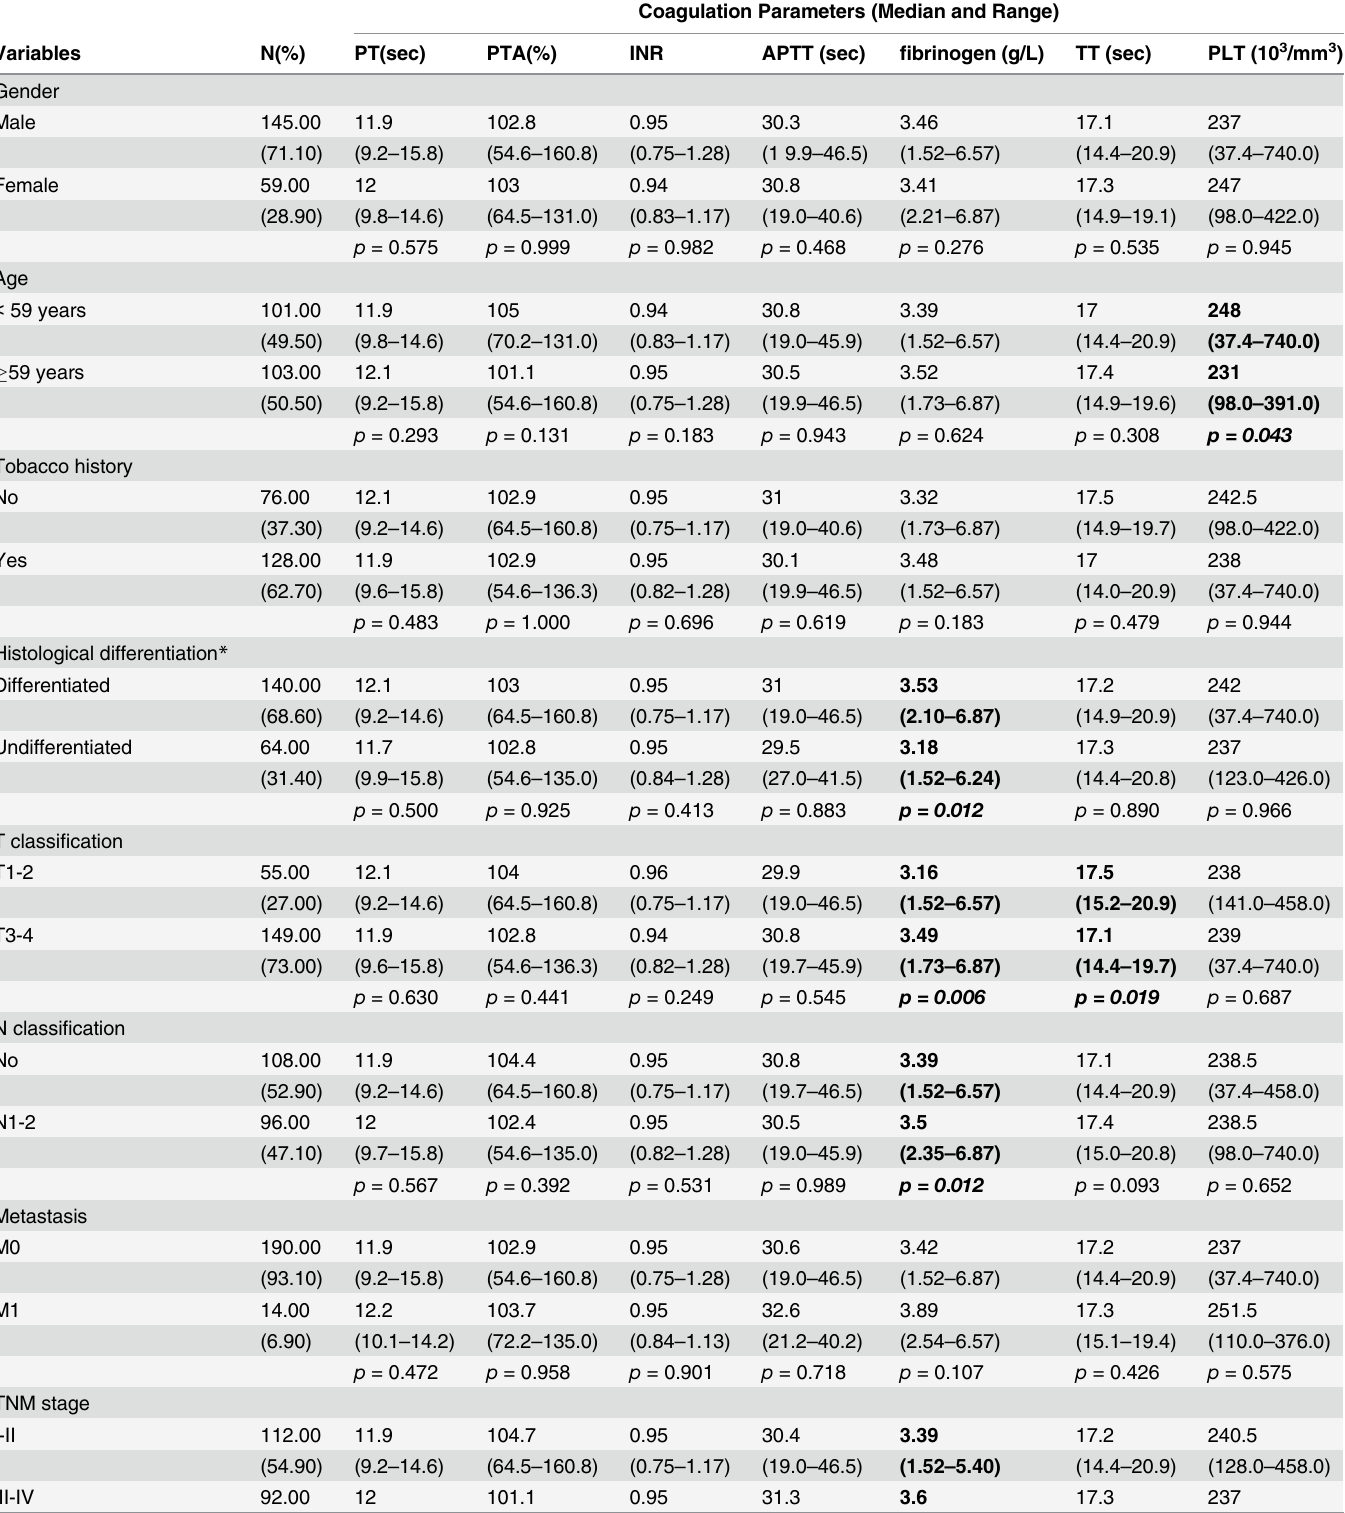
Table 2. Main Clinical Characteristics of Patients Group According to Coagulation Parameter Levels. Coagulation Parameters (Median and